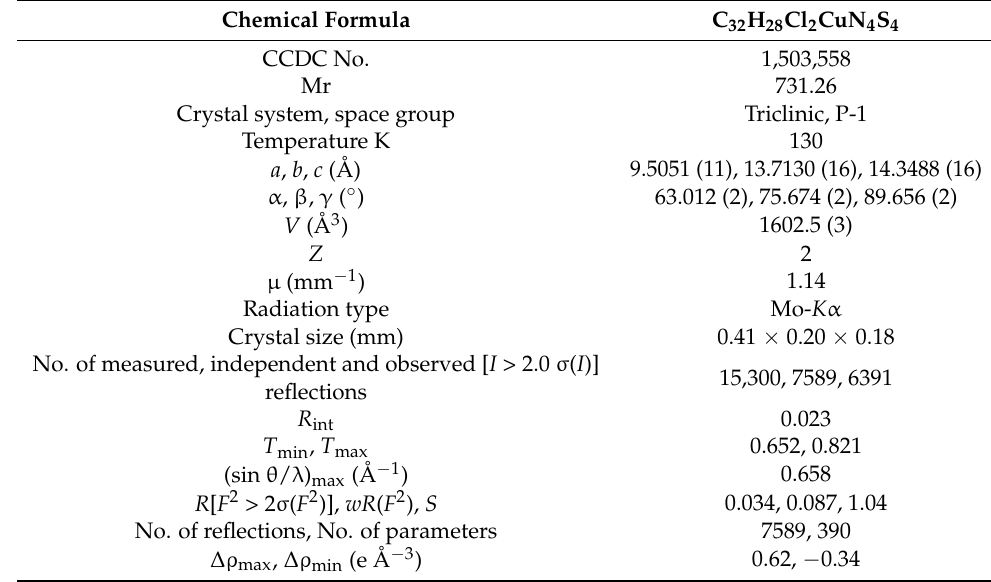
Table 1. Structure refinement and crystal data and of Cu(II)